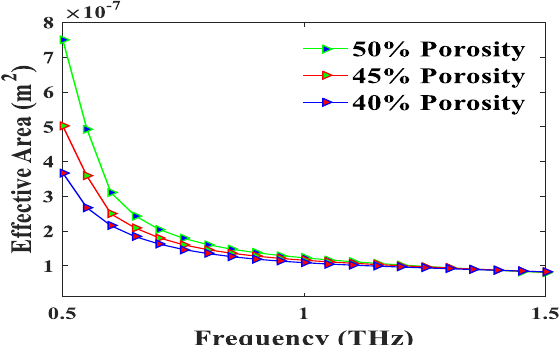
Figure 3. The effective area of optimum structure as a function of frequency.